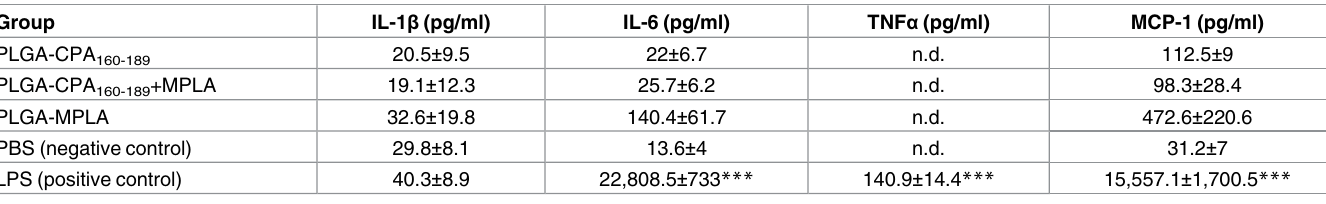
Table 3. Detection of induction of acute inflammation after PLGA NPs injection.